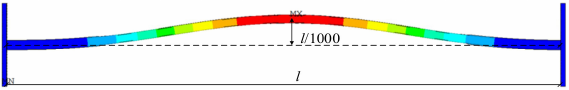
Figure 10. Initial imperfection of core